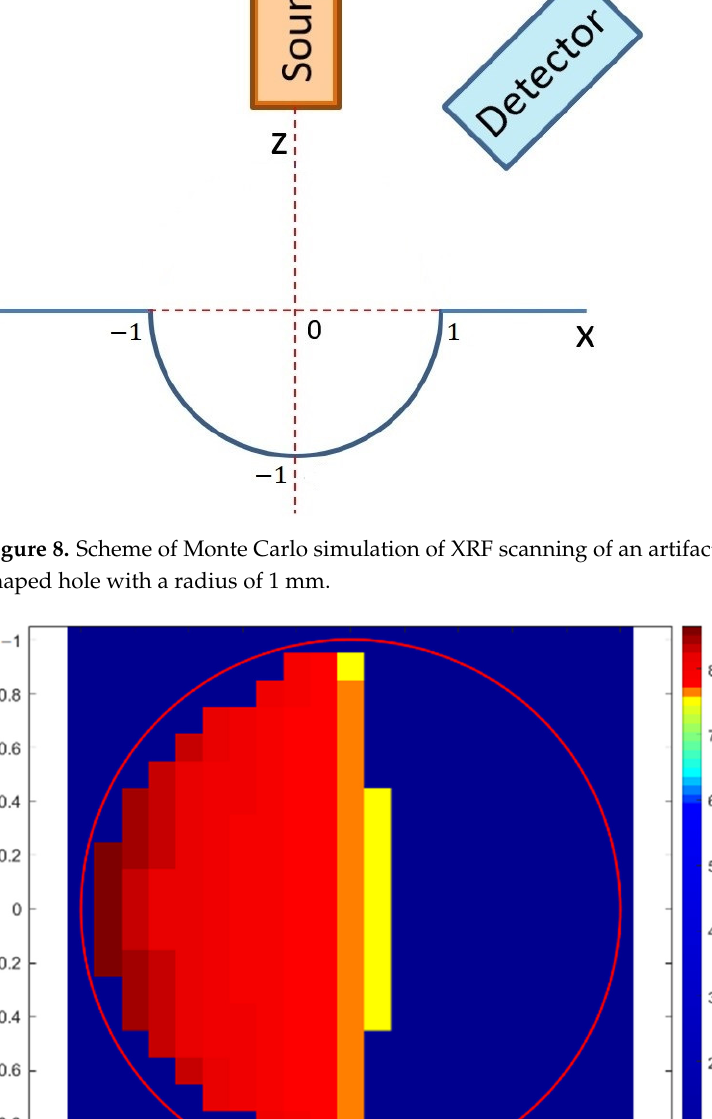
Figure 10. Copper concentration map of sterling silver sphere-shaped hole determined with Monte Carlo simulation of XRF scanning applying Cu-K α and Ag-K α lines. The correct Cu concentration was 7.5%.